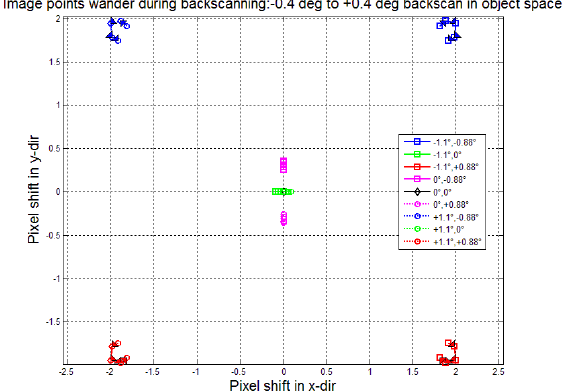
Figure 6. Grid distortion. The X point is the actual field point, and the grid is the theoretical field point. In order to visually display the distortion characteristics, the distortion deviation is enlarged by 20 times.